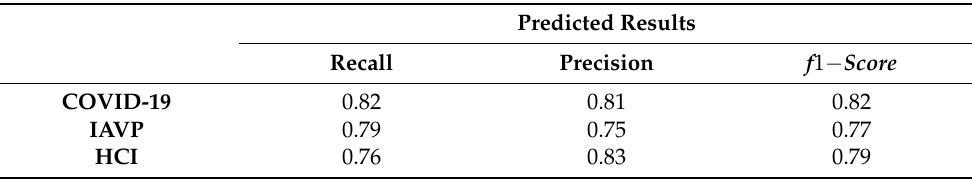
Table 6. Model performance evaluation metrics on recall, precision, and f1-score of Bayesian classifi- cation models for COVID-19, IAVP, and a healthy candidate without infection